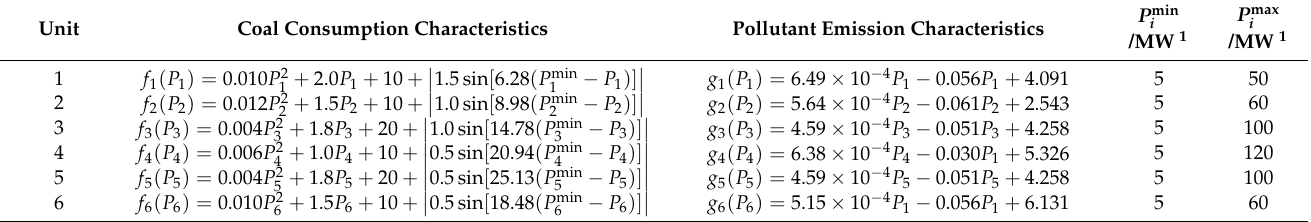
Table 5. Characteristics of dispatched units based on economy and environmental protection.